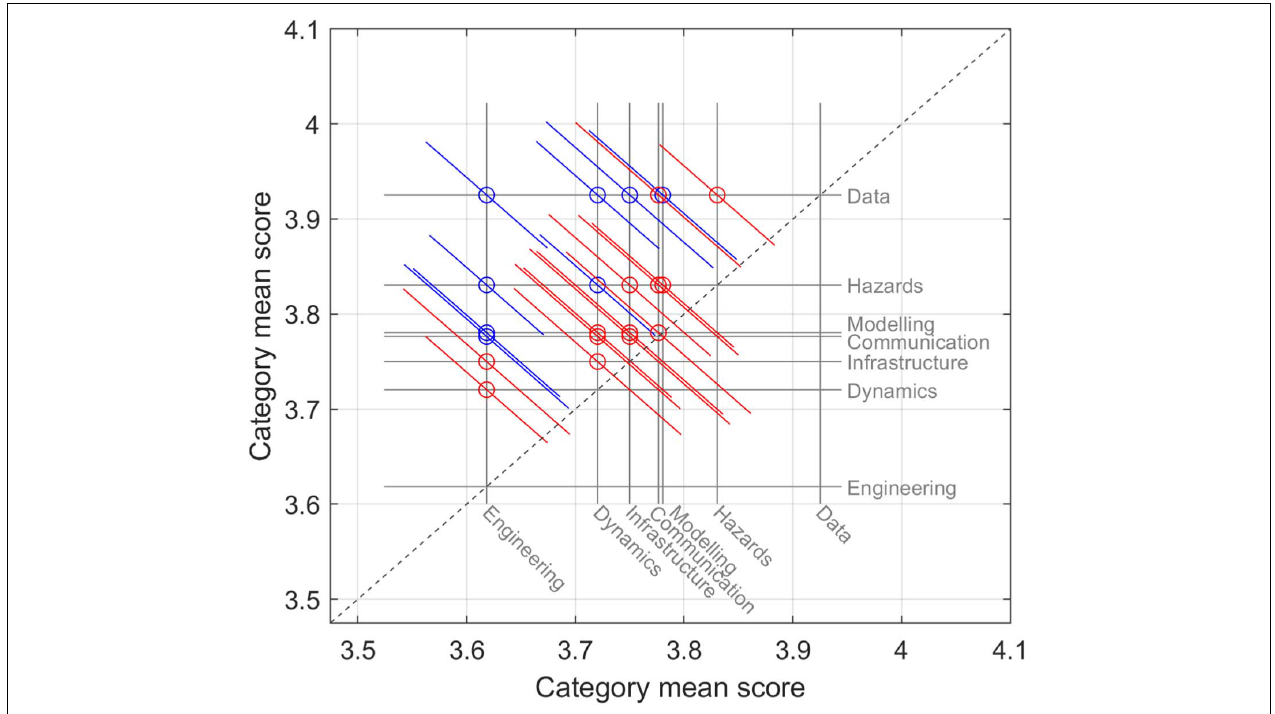
FIGURE 4 | Diffogram showing multiple comparisons of the mean scores of the categories based on the results of the one-way ANOVA test. Horizontal and vertical grey reference lines display the means of each category. Open circles represent comparisons of all 21 pairs of means and straight lines represent 95% confidence intervals. Blue circles and lines represent pairs of means that are significantly different from each other at the p = 0.05 level. Red circles and lines indicate pairs of means that are not significantly different from each other, i.e., those with confidence intervals that intersect the diagonal reference